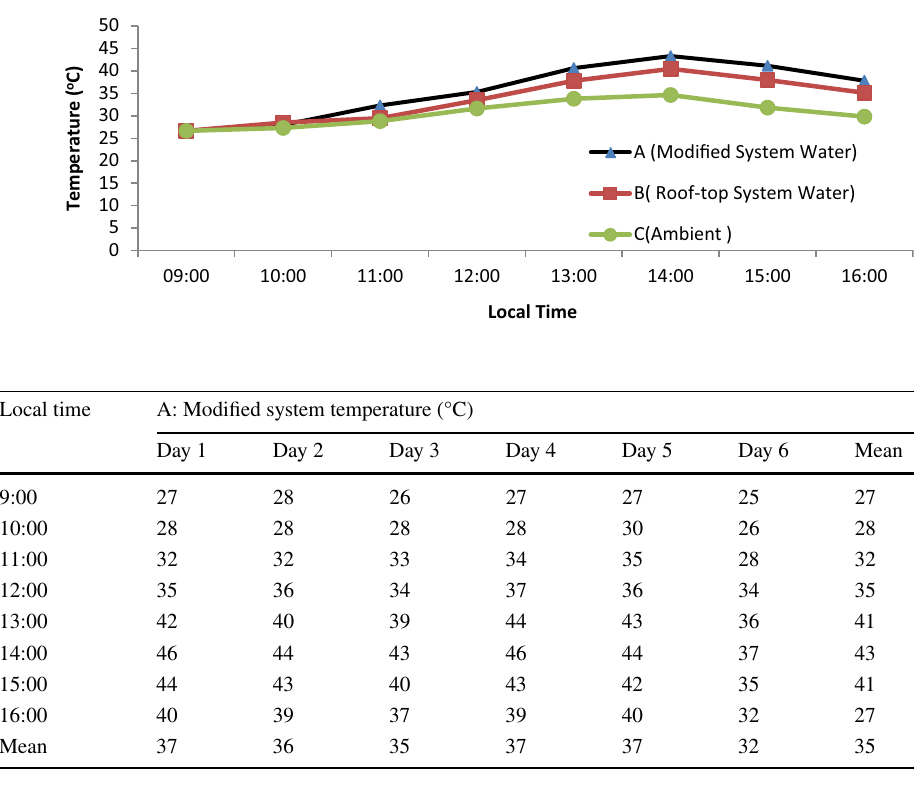
Fig. 6 Mean variations in temperatures